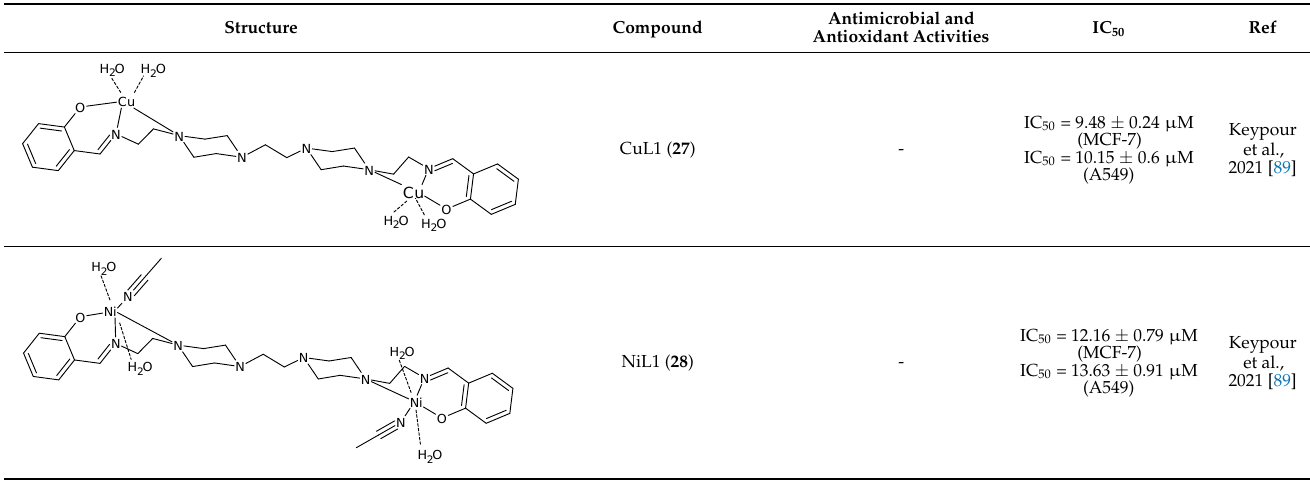
Table 3. Binuclear metal complexes with SBs.